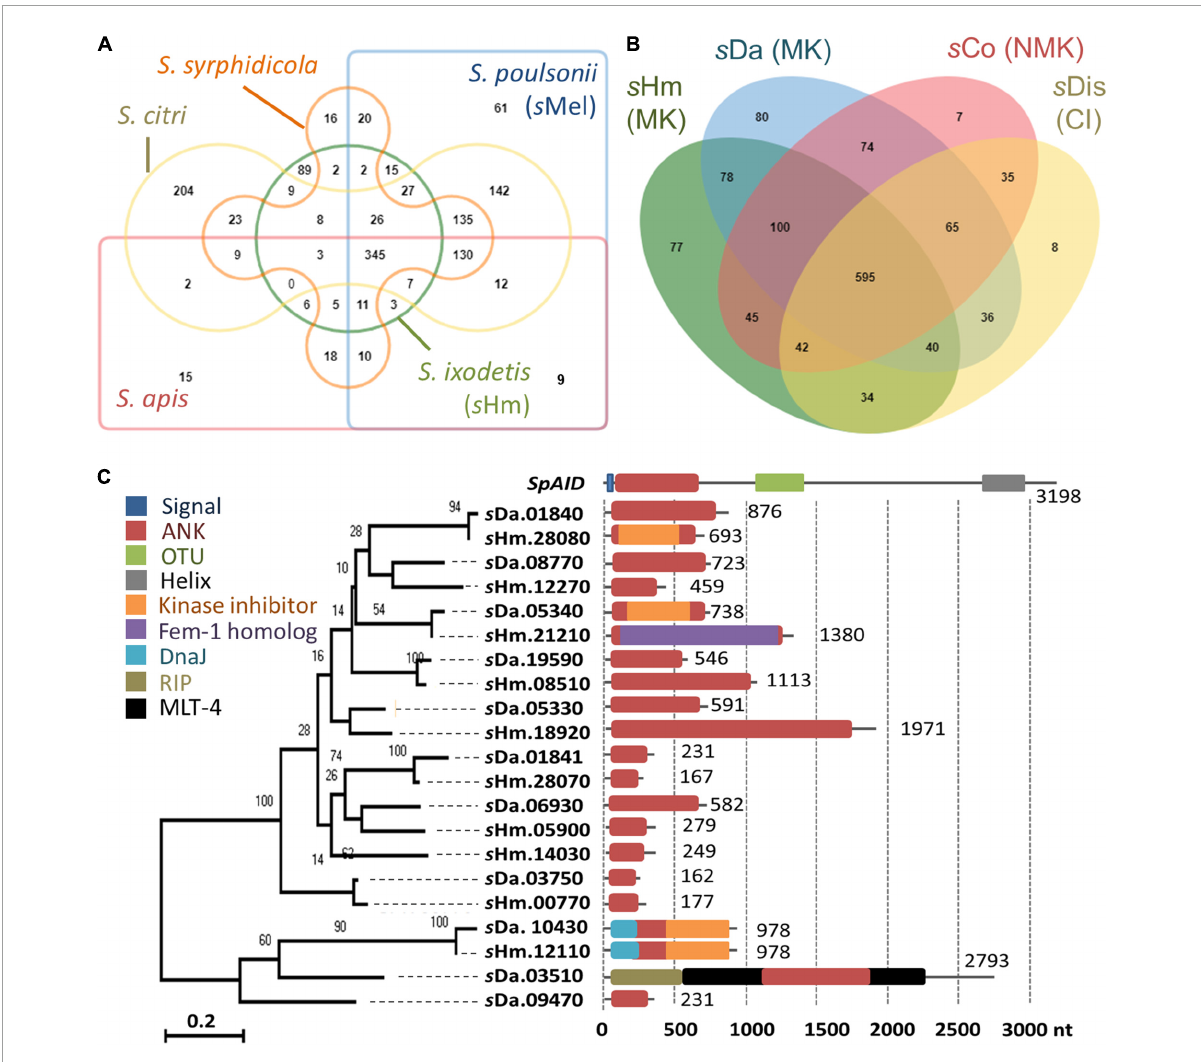
FIGURE3 Comparison of Spiroplasma genomes and ankyrin genes. (A–B) Protein clusters conserved within Spiroplasma species ( S. apis, S. citri, S. ixodetis, S. poulsonii , and S. syrphidicola ) (A) and within S . ixodetis strains ( s Hm, s Da, s Coc, and s Dis) (B) . Venn diagrams were visualized using OrthoVenn2. The s Hm-specific protein clusters and their functions are shown in Supplementary Table 1 . MK, male-killing strain; NMK, non-male-killing strain; CI, cytoplasmic incompatibility strain. (C) Phylogeny of ankyrin genes in Spiroplasma strains s Hm and s Da. Numbers indicates nucleotide length (nt). Other domains of the genes are highlighted in different colors. Red: ankyrin; Blue: signal peptide; Green: OTU; Gray: transmembrane helix; Orange: cyclin-dependent kinase inhibitor; Purple: ubiquitination associated FEM1A_DROME; Sky blue: DNA J; Khaki: Ribosome–inactivating protein (RIP); Black: molting protein